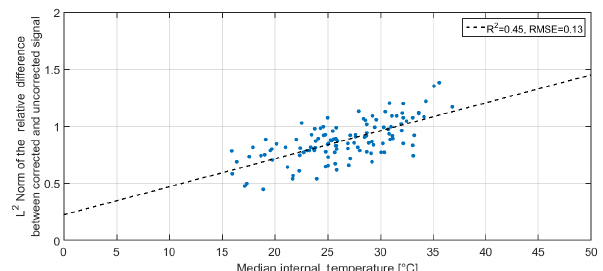
Figure 6. Relative difference between corrected and uncorrected signal against internal temperature.